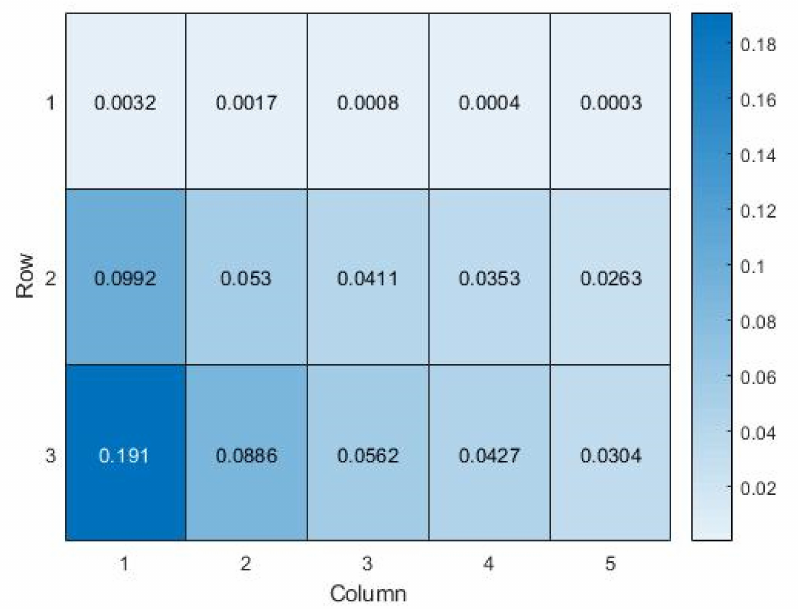
Figure 27. Diffuse shading factor f D for all the modules in the